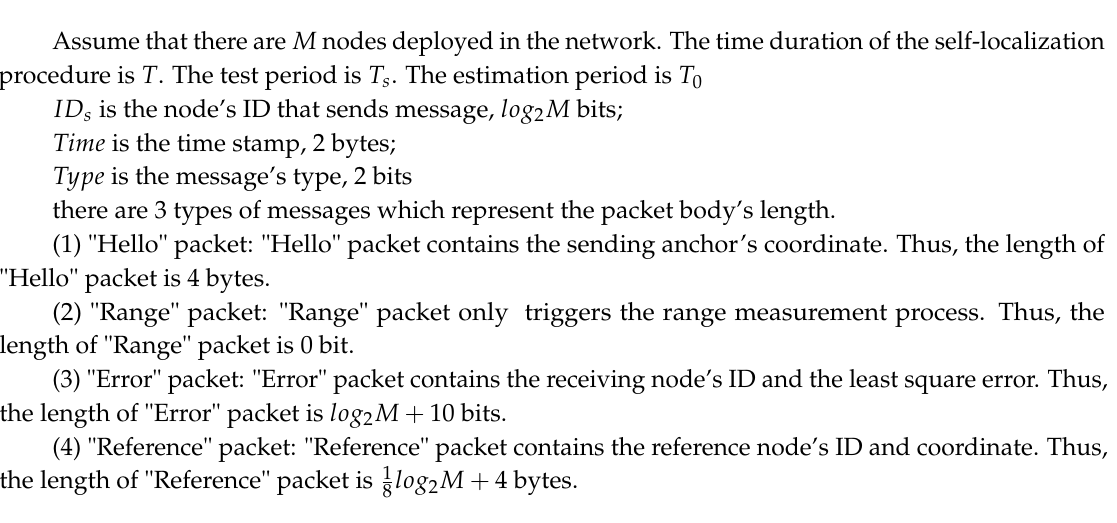
Figure 14. The packet